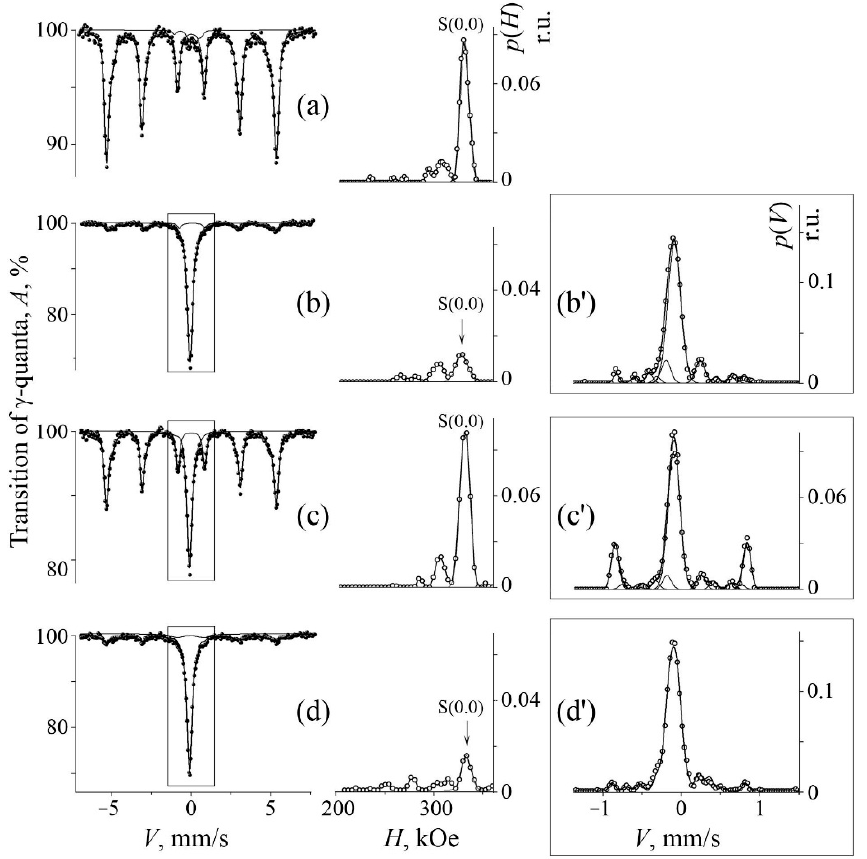
Figure 4. Mössbauer data of the MA samples after BM and annealing of Series A : ( a – d ) distributions of the p ( H ) of the sextet for the α phase; ( b’ – d’ ) distributions of the p ( V ) of the center of the spectra. Treatment, composition: ( a ) BM, annealing at 700 °C, 1 h, composition 3 (Fe–6.7Mn + 20% CrN); ( b , b’ ) BM, annealing at 800 °C, 1 h, composition 3 (Fe–6.7Mn + 20% CrN); ( c , c’ ) BM, annealing at 800 °C, 1 h, composition 4 (Fe–8.9Mn + 20% CrN); ( d , d’ ) BM, annealing at 800 °C, 1 h, composition 4 (Fe–8.9Mn + 20% CrN).